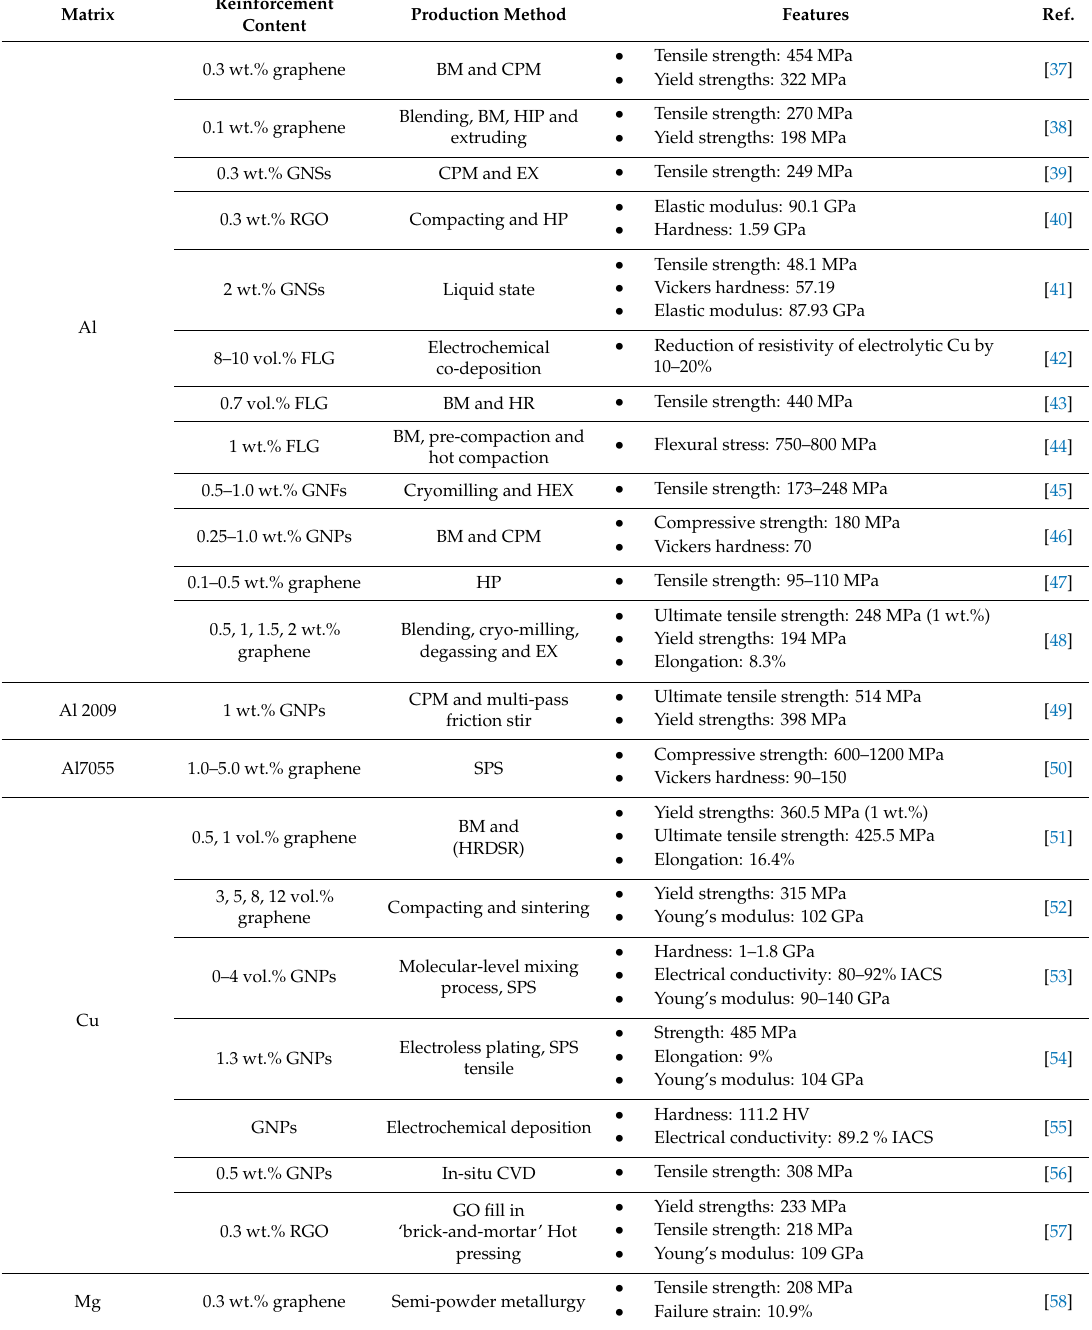
Table 1. Summary of research on metal matrix nanocomposites (MMNCs) reinforced by graphene.